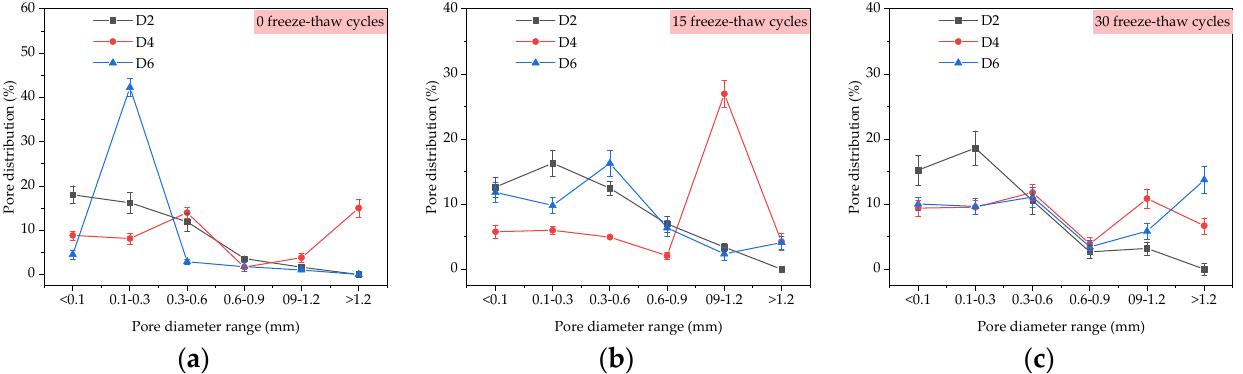
Figure 8. Pore distribution under the influence of polypropylene fiber: ( a ) 0 freeze-thaw cycles; ( b ) 15 freeze-thaw cycles;